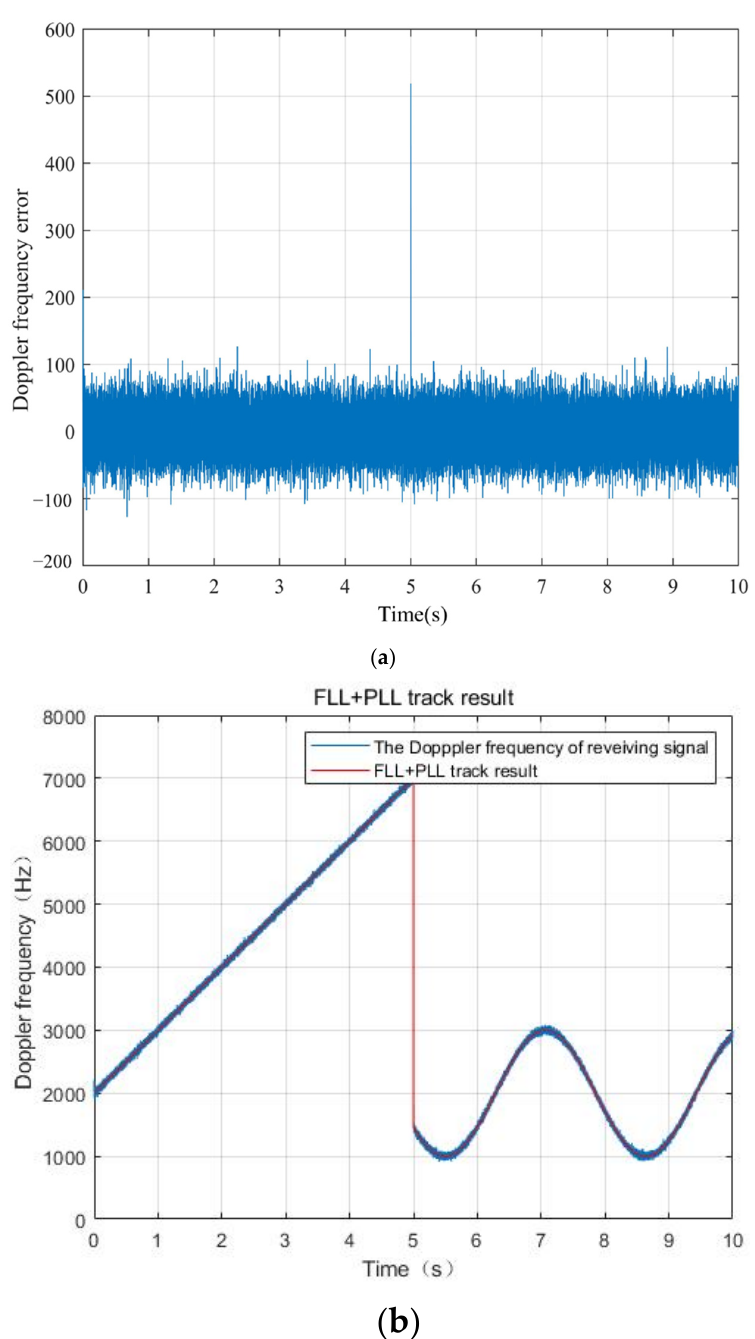
α β= Figure 16. The switching time when α : β = 0.1 : 0.9 and C / N 0 = 45 dB-Hz. ( a ) the Doppler frequency Figure 16. The switching time when : 0.1: 0.9 and C/N0 = 45 dB-Hz. ( a ) the Doppler error, and ( b ) the Doppler frequency frequency error, and ( b ) the Doppler frequency measurement.